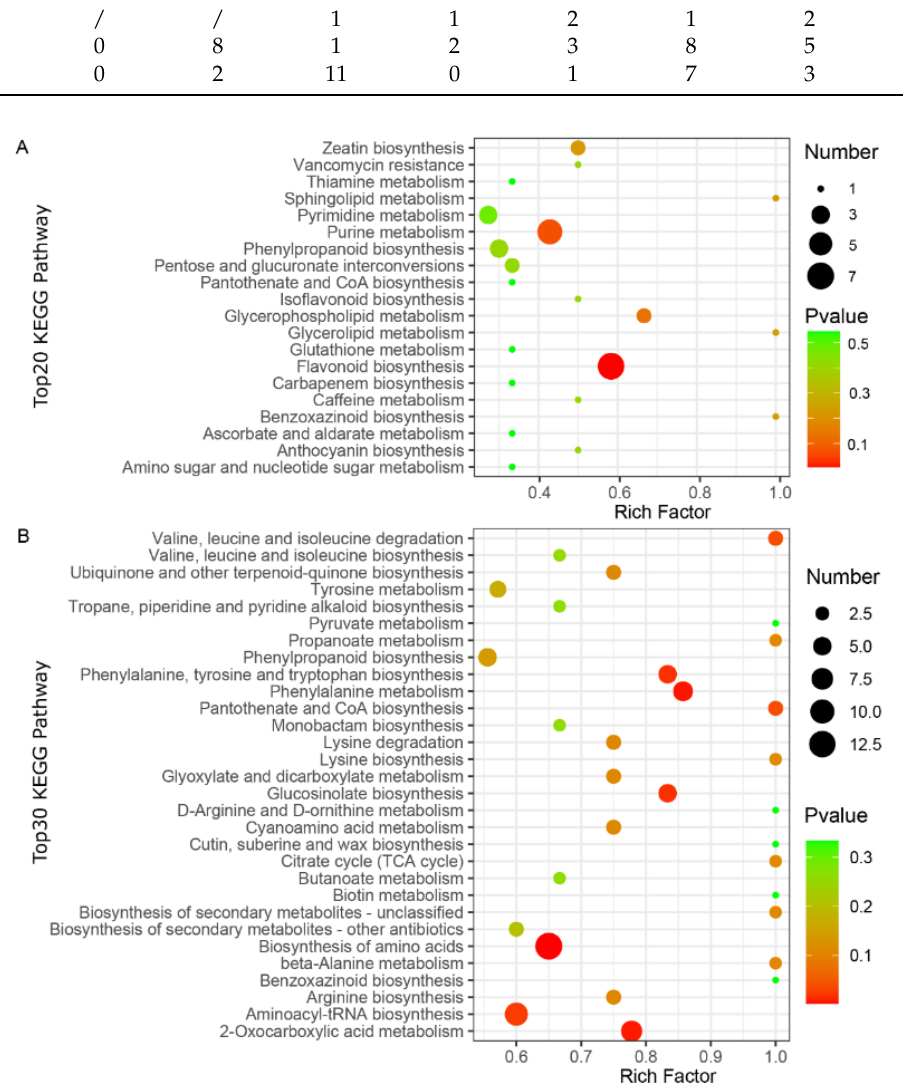
Figure 4. KEGG enrichment analysis of the differentially accumulated metabolites (DAMs) in CL and LP. ( A ) The bubble diagram showing the top20 KEGG pathway enriched for DAMs in LP comparing “JX” with “CA”. ( B ) The bubble diagram showing the top30 KEGG pathway enriched for DAMs in CL comparing “JX” with “CA”. “CA”, China Antique; “JX”, JianXuan-17; CL, cotyledon; LP; lotus plumule; KEGG, Kyoto Encyclopedia of Genes and Genomes.